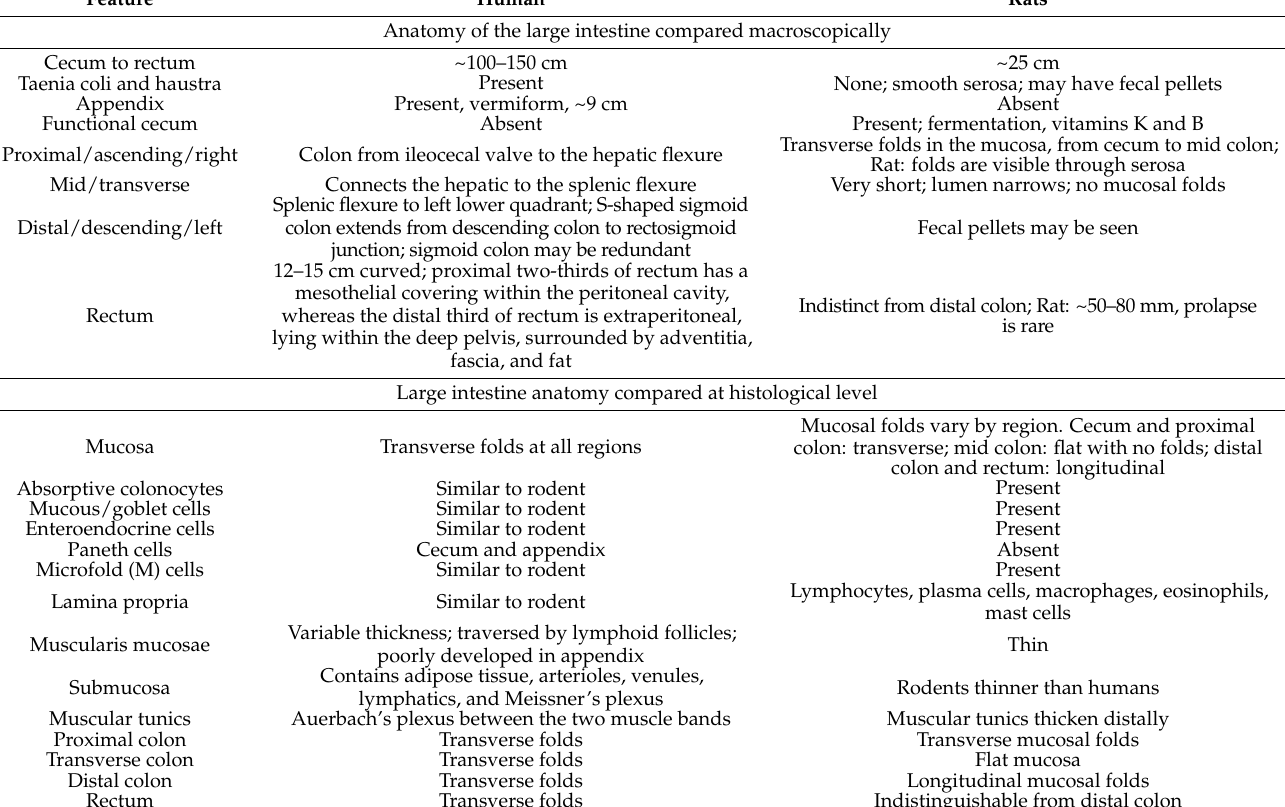
Table A1. Comparison of anatomical differences of human and murine colon (adapted from reference